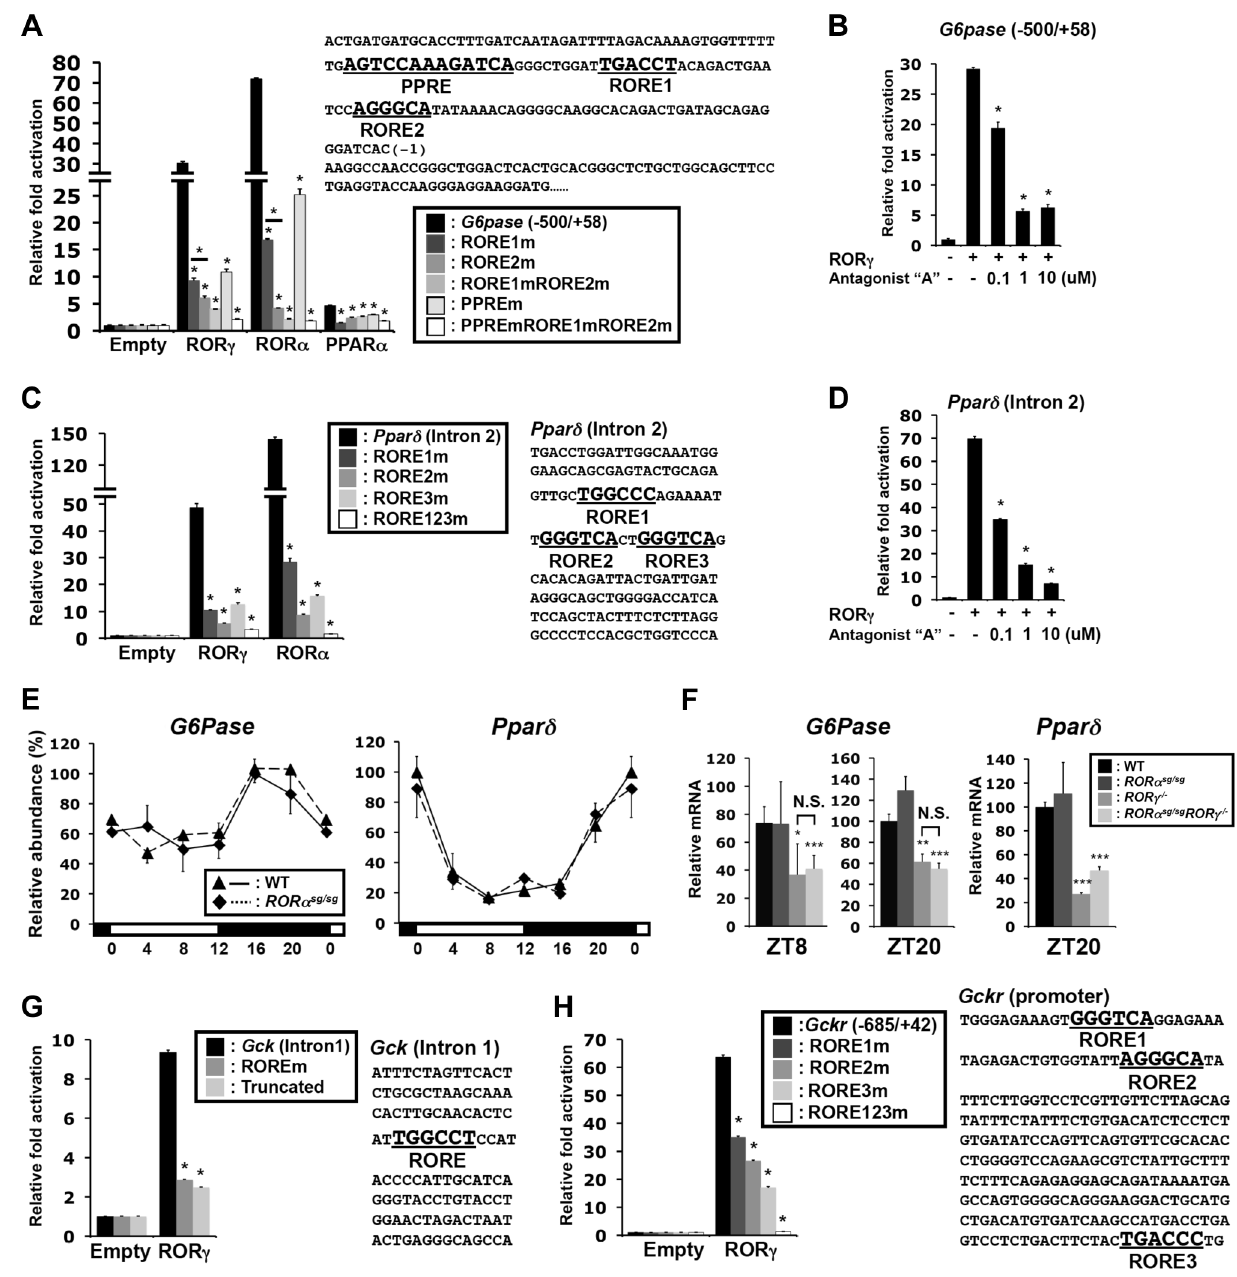
Figure 6. Transcriptional regulation of glucose metabolic genes by ROR c . ( A ) Sequence and activation of the ROR c binding region of the G6pase ( 2 500/ + 58) proximal promoter. The ROREs and PPRE are indicated in bold. Activation of the G6pase promoter by ROR c was examined by transfecting Huh-7 cells as indicated with pCMV- b -Gal, pCMV10-3xFlag-ROR c , -ROR a or -PPAR a (with 10 m M Wy14,643) expression vectors and a pGL4.10 reporter driven by G6Pase ( 2 500/ + 58) or the promoter in which the RORE and PPRE were mutated. Luciferase activities were normalized to the control transfected with the empty expression vector. ( B ) Inhibition of the activation of the G6pase ( 2 500/ + 58) promoter by ROR c -selective antagonist ‘‘A’’. ( C ) Activation of the Ppar d regulatory region by ROR c . Sequence of the ROR c binding region in intron 2 of Ppar d . The three potential ROREs are indicated in bold. Huh-7 cells were co-transfected with pCMV- b -Gal, pCMV10-3xFlag-ROR c or -ROR a expression vector, and the pGL4.27 reporter plasmid containing the Ppar d (intron 2) or the intron in which the ROREs are mutated. ( D ) Inhibition of the activation of the Ppar d (intron 2) by the ROR c -selective antagonist. Data represent mean 6 SEM, * P , 0.05 by ANOVA. ( E ) Loss of ROR a does not affect the circadian expression of G6pase and Ppar d in liver of WT and ROR a sg/sg mice (n=4). ( F ) Comparison of G6pase and Ppar d expression in liver collected from WT, ROR a sg/sg , ROR c 2 / 2 , and ROR a sg/sg ROR c 2 / 2 DKO mice at ZT8 and ZT20. Data represent mean 6 SD, * P , 0.05, ** P , 0.01, *** P , 0.001 by ANOVA. ( G ) Huh-7 cells were co-transfected with pGL4.27 in which the reporter was under the control of Gck (intron 1) or Gck (intron 1) containing a mutated RORE or truncated Gck (intron 1) without the RORE. ( H ) Huh-7 cells were co-transfected with pGL4.10 plasmid containing the mouse Gckr promoter ( 2 685/ + 42) or the promoter containing mutated ROREs. Data represent mean 6 SEM, * P , 0.05 by ANOVA.